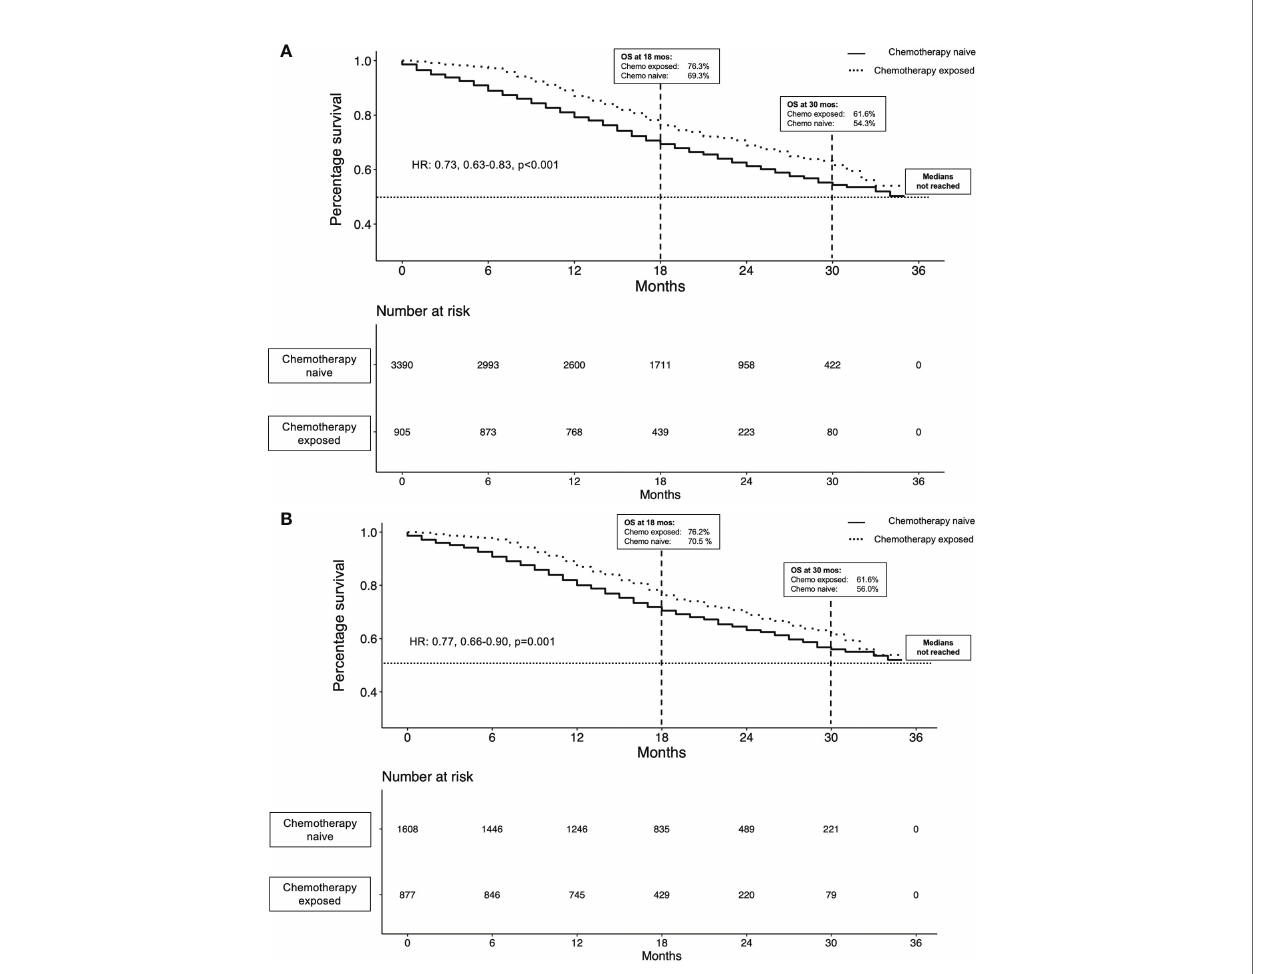
FIGURE 1 | Kaplan-Meier plots illustrating overall survival in metastatic prostate cancer (mPCa) patients (n=2495) prior to propensity score matching (A) and in 2490 mPCa patients after propensity score matching (B) , strati fi ed by chemotherapy